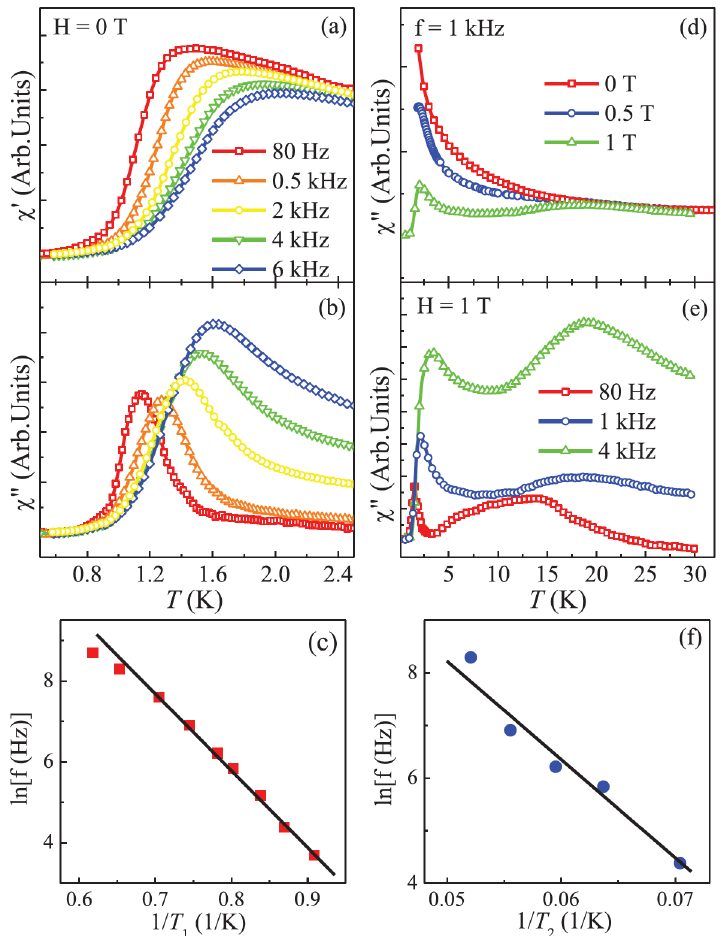
Figure 6. (color online)Temperature dependence of ( a ) the real part χ (cid:48) and ( b ) the imaginary part χ ” of the ac susceptibility for Ho 2 Ge 2 O 7 below 3 K; ( c ) Arrhenius law fit of the low-temperature peak position in χ ”; ( d ) high-temperature χ ” at f = 1 kHz with varying field strength; ( e ) high-temperature χ ” at H = 1.0 T with varying frequency; ( f ) Arrhenius law fit of the high-temperature peak position in χ ”. From Ref.